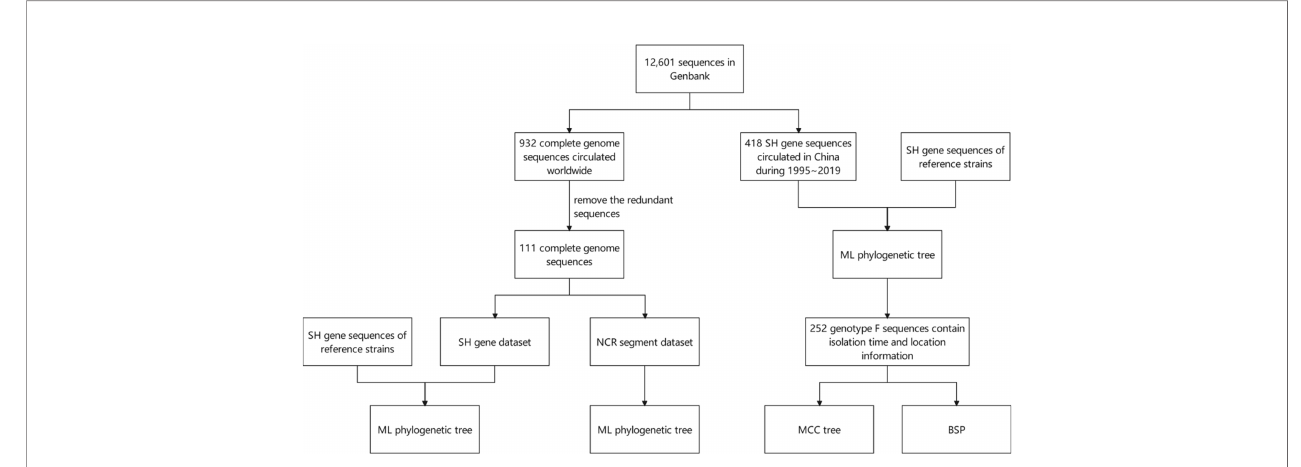
FIGURE 1 | Schematic diagram of the analysis fl ow. SH, small hydrophobic; NCR, non-coding region; ML, maximum likelihood; MCC, Maximum Clade Credibility; BSP, Bayesian skyline